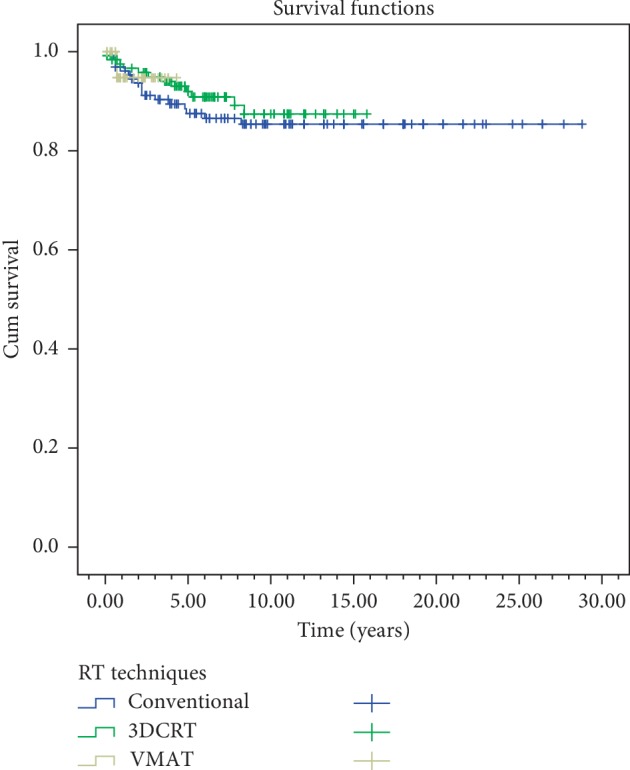
Local control curves by RT technique.